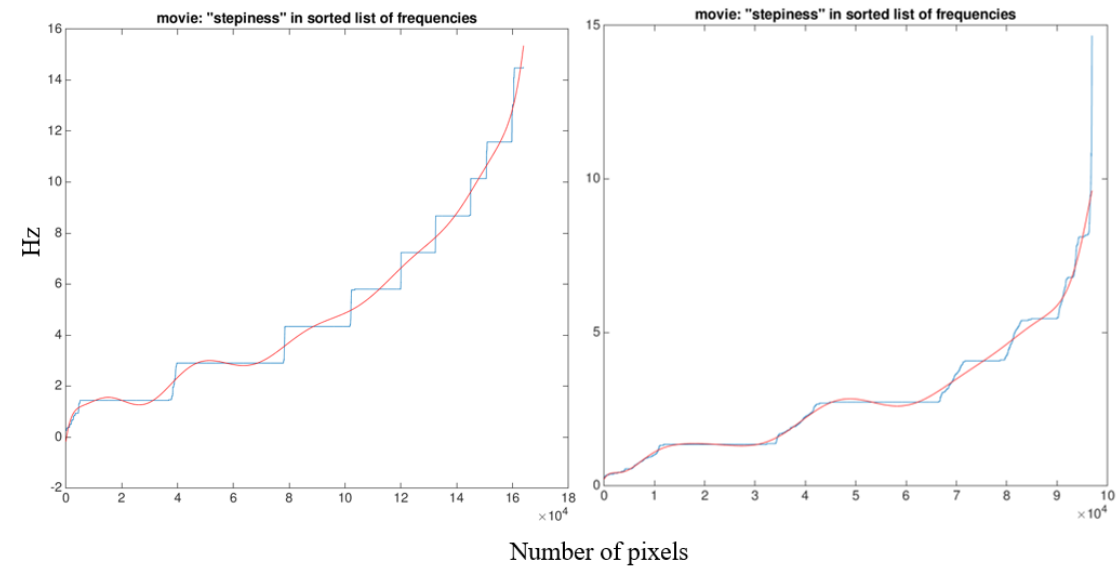
Figure 3. Exported directly from the Graal software output, the left panel shows the frequency-distribution plot in blue and the polynomial fitting function in red of a high-level runner, adapted to the use of treadmill running with a well-coordinated motion pattern. The right panel shows the irregular, worse-quality running gait of a recreational runner, a novice in the use of a treadmill.